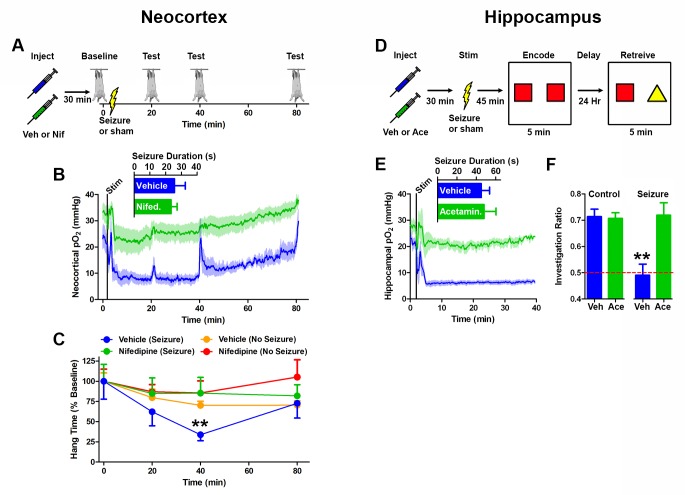
Preventing postictal severe hypoxia prevents behavioral impairments.(A) Experimental timeline for neocortex experiments. Rats were injected with vehicle or nifedipine 30 min prior to a baseline hang time measurement. Neocortical seizures (or sham) were then elicited and rats were retested at 20, 40, and 80 min post-seizure. (B) Nifedipine pre-treatment (15 mg/kg) inhibited severe hypoxia during the postictal period (n = 4). Inset reveals no difference in seizure duration. Note that during task performance motor cortex pO2 levels temporarily increased while the rat hung from the bar, likely mediated by increased blood pressure, but returned to pre-test levels following release from the bar. (C) Performance on the hanging bar task was steady across the experiment, except in the vehicle+seizure group (hypoxic) (n = 4 for seizures, n = 3 for no seizures). A significant decrease was observed at 40 min post-seizure, which recovered by 80 min. Data are mean ± SEM. **p<0.01 (2 way ANOVA). (D) Experimental timeline for hippocampus experiments. Rats were injected with vehicle or acetaminophen (250 mg/kg) 30 min prior to hippocampal seizure induction (or sham). 45 min post-seizure, rats were place in testing environment to encode the memory of 2 identical objects. 24 hr later, memory was tested by measuring the percentage of time spent investigating the novel object. (E) No differences were observed in seizure duration (n = 4). Acetaminophen prevented postictal hypoxia. (F) Rats that had seizures and vehicle treatment (hypoxic) performed no different from chance and significantly worse than all other groups (n = 4). Data are mean ± SEM. **p<0.01 (ANOVA).